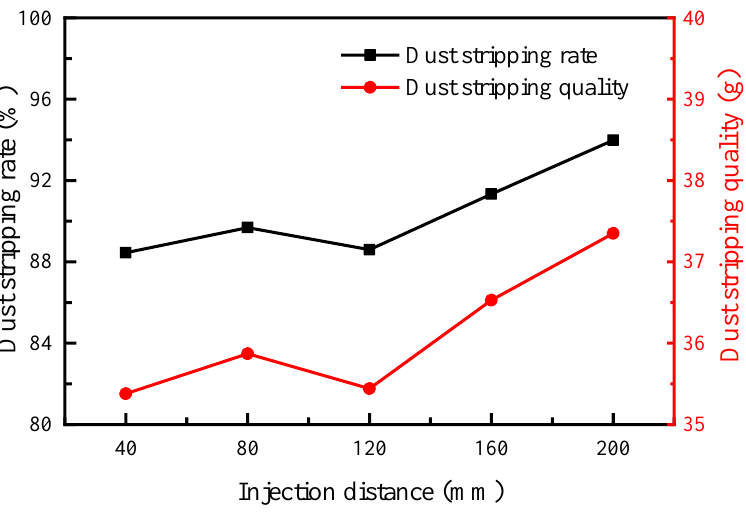
Figure 7. The effect of injection distance on dust stripping rate (DSR).